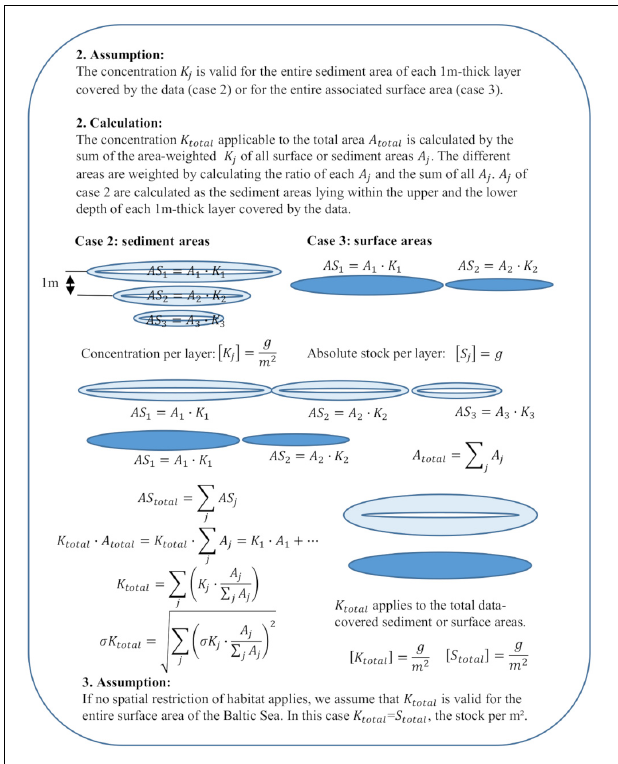
FIGURE 4 | Calculations and assumptions for case 2 and case 3 stocks. AS j , absolute stock of layer j; AS total , total absolute stock of the entire area A total ; S total , total stock in g/m 2 ; A total , total area; A j , sediment (case 2) or surface area (case 3); K j , mean concentration of the area in g/m 2 ; σ K j , standard deviation of the mean concentration per area; K total , weighted concentration of all areas covered by data; and σ K total , standard deviation of the mean